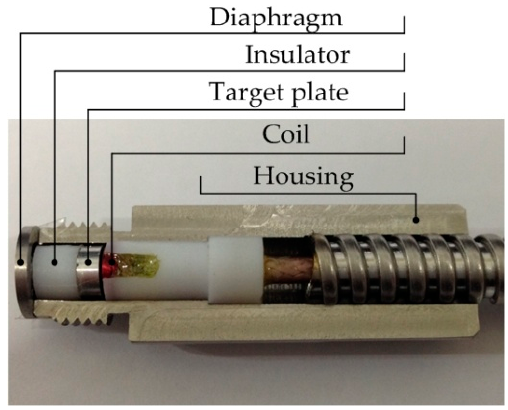
Figure 13. Cross section view of an assembled pressure sensor.